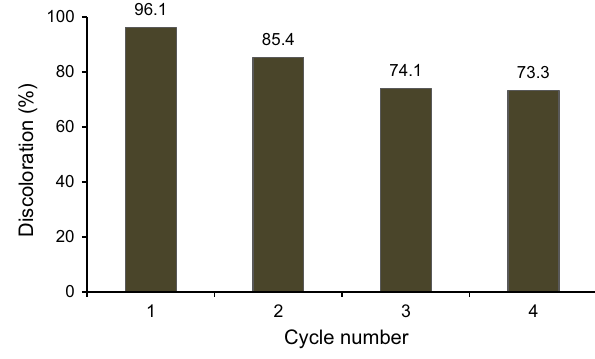
Fig. 10 Spectral variation of Rhodamine B during treatment ( C 0 = 50 mg/L and 28 °C, pH = 4.2; AC@Fe/3 0.27 g/L; 8 mmol/L of H